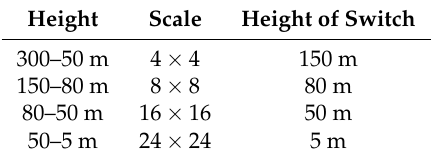
Table 1. Change of the averaging level as a function of the height